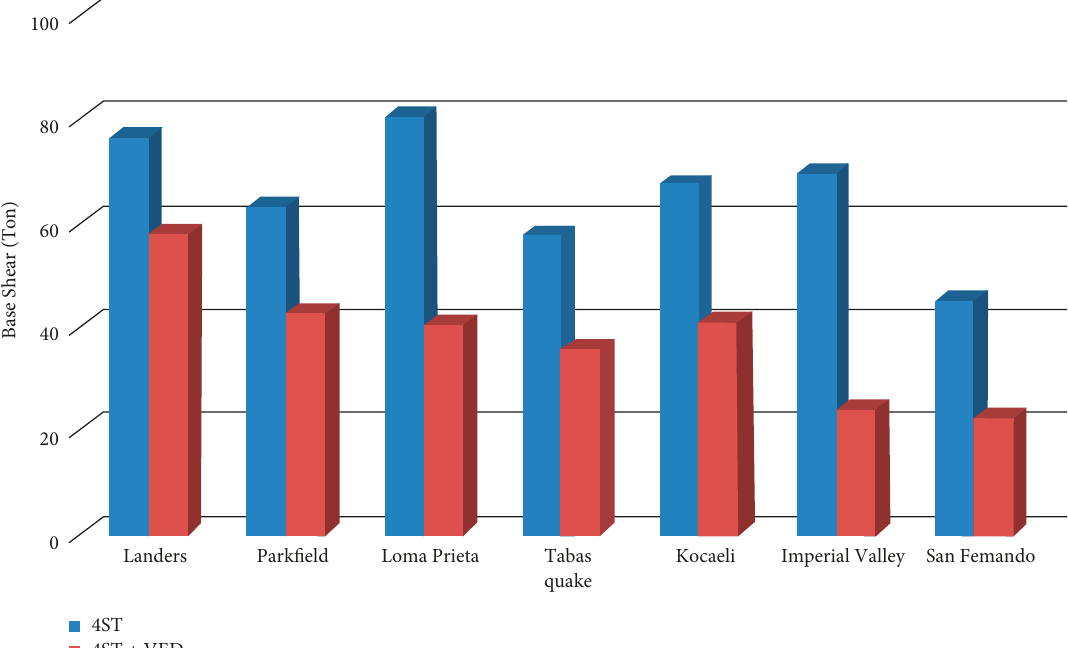
Figure 16: Shear base of an 8-story frame under near-field records in two modes with and without dampers (tons).